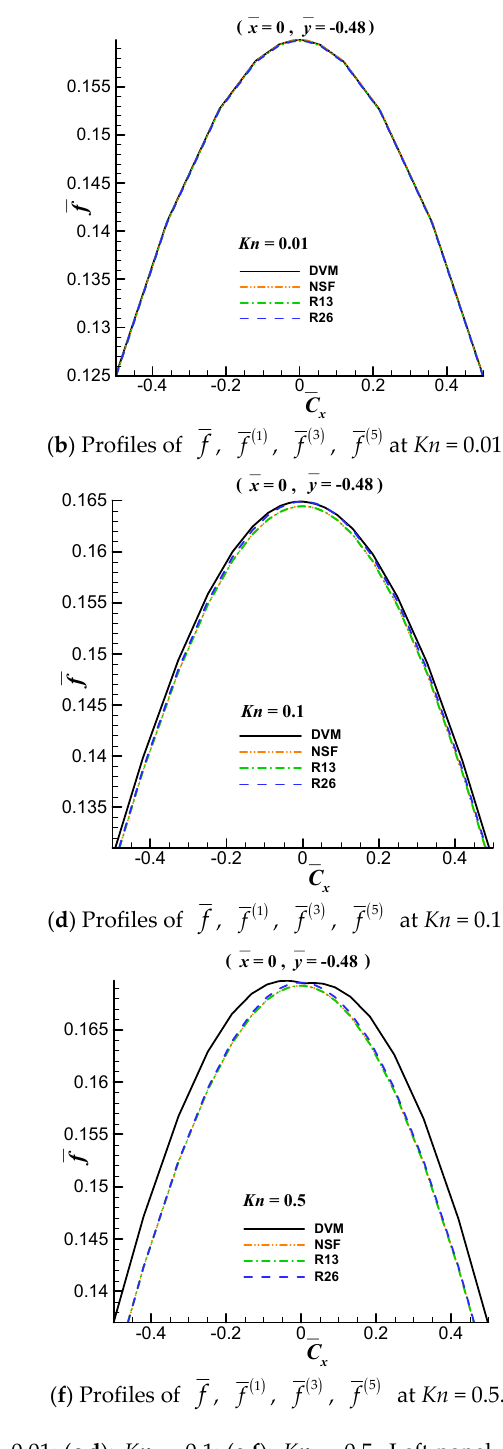
( 5 ) ( 3 ) ; red dash dot lines: f . The remaining